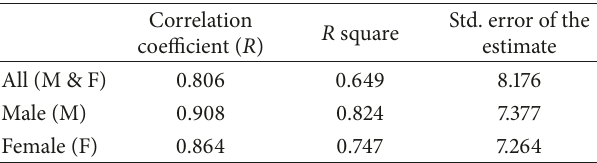
Table 5: Karl Pearson’s correlation coefficient ( 𝑅 ), coefficient of determination ( 𝑅 2 ), and standard error of the estimates for the collected data.